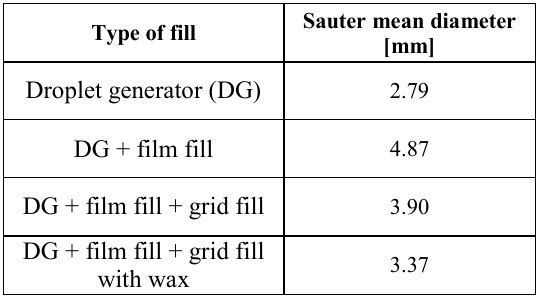
Table 2. Sauter mean diameter of